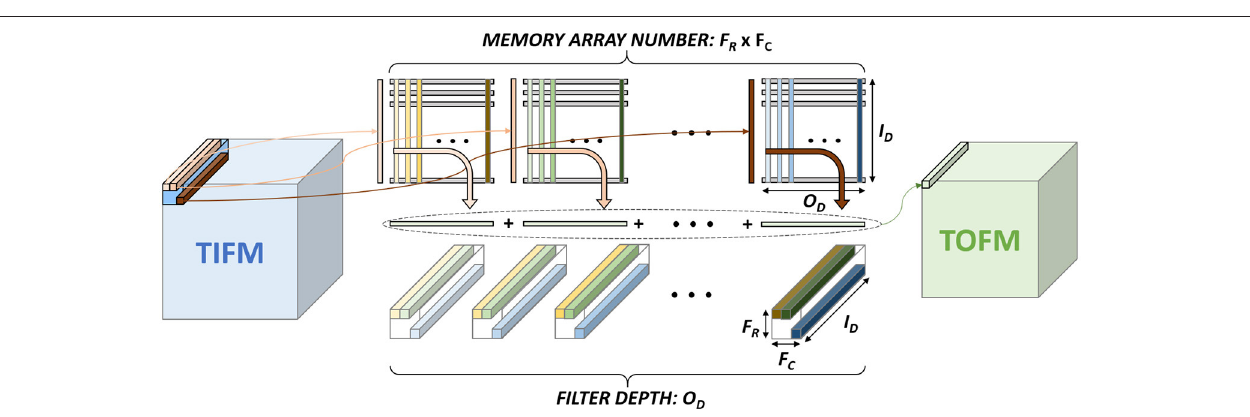
FIGURE 5 | CNN mapping on the memory for processing-in-memory (PIM) architecture.